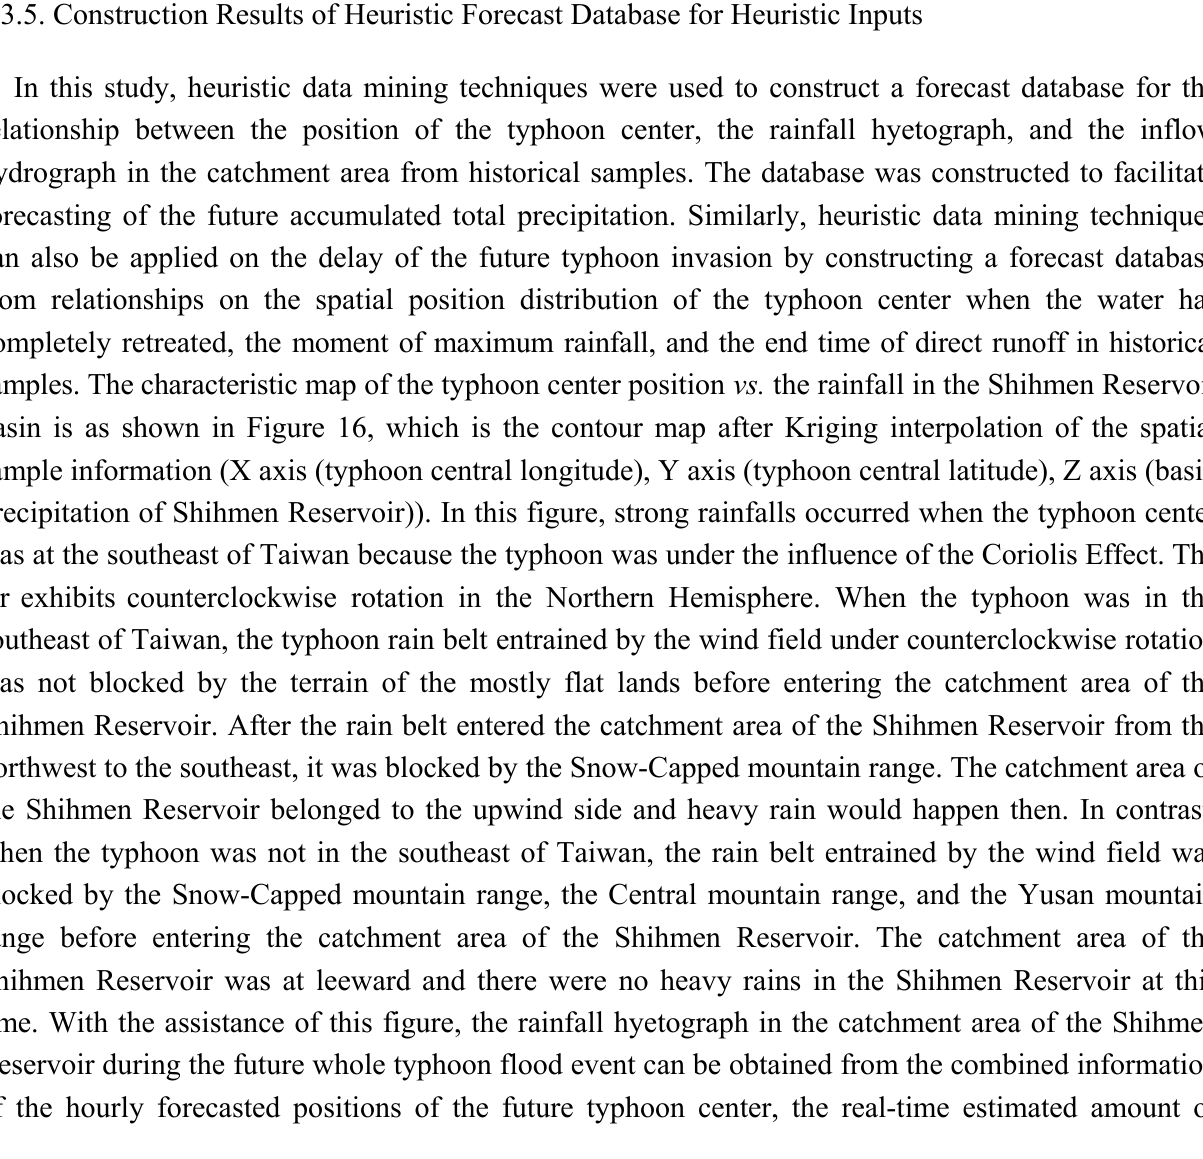
Figure 15. Sensitivity analysis results of model output with relation to single or combined heuristic inputs due to future forecasted